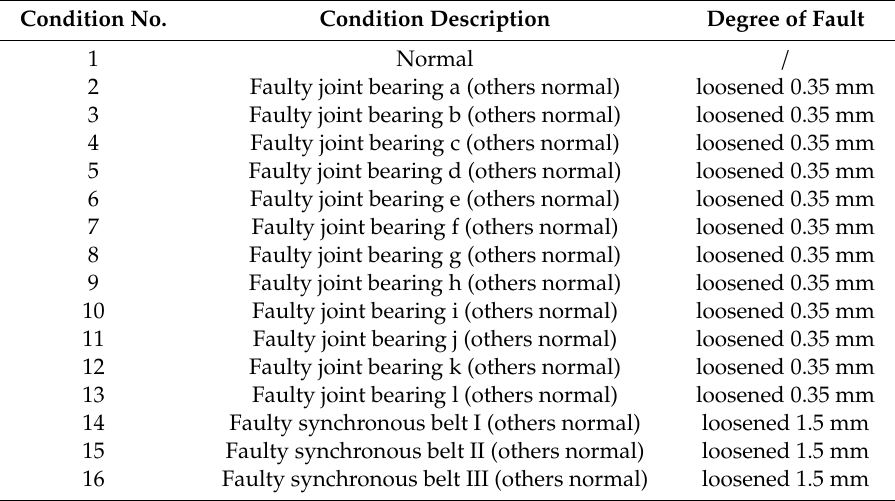
Figure 4. Experiment flow chart. Table 1. Conditions of the delta 3D printer designed in the experiment.